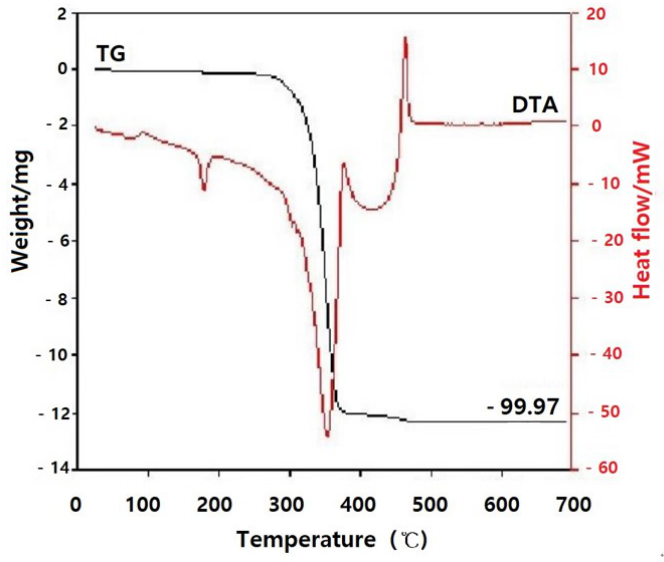
Figure 7. Thermal analysis system. Ash fraction of the film was less than 0.05% (TG, thermal gravity). The film was volatilized over the temperature range of 300 to 400 °C (DTA, differential thermal analysis).